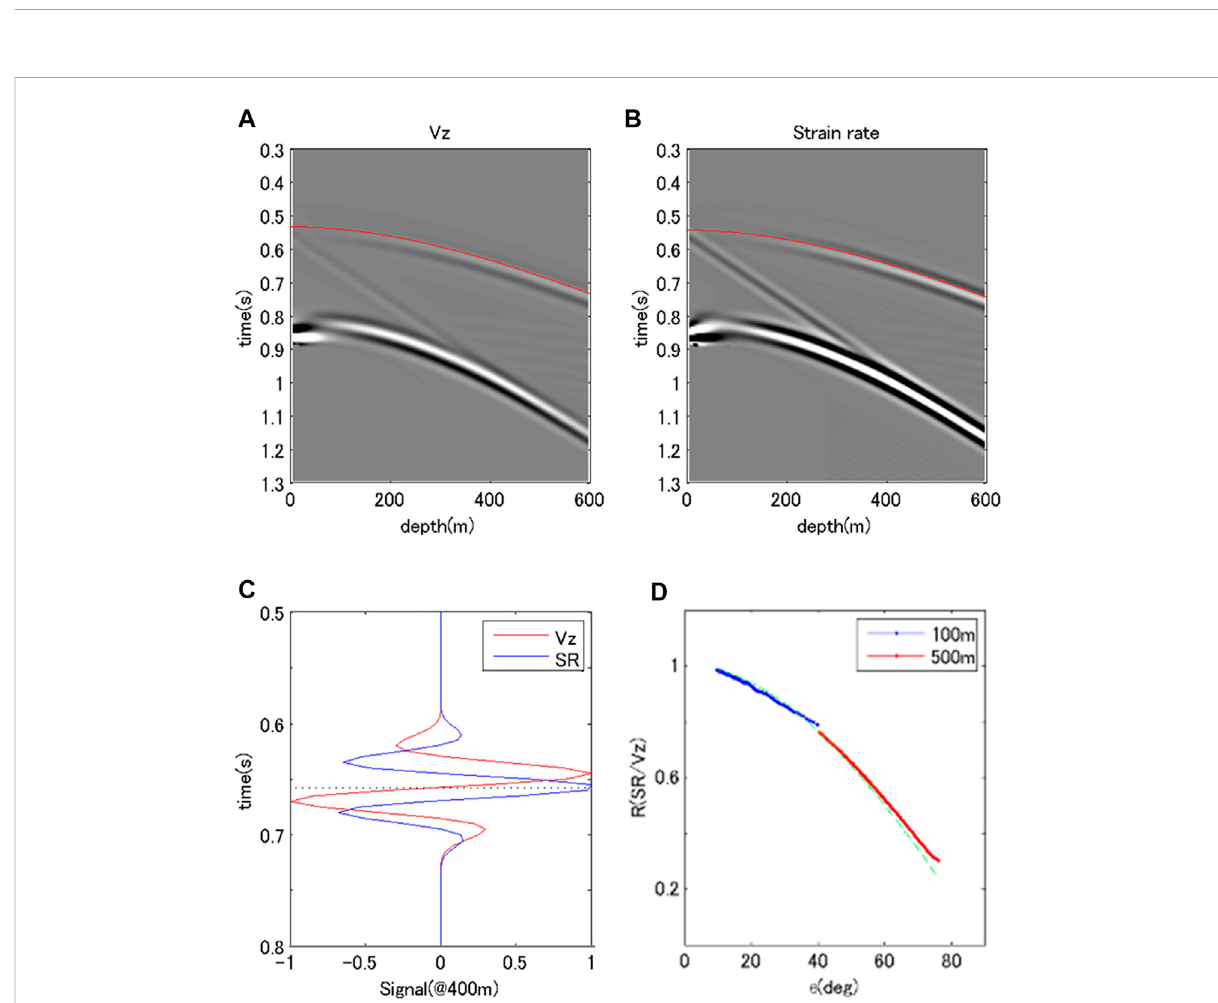
FIGURE 1 Characteristics of the synthetic wave fi eld in a homogeneous model. (A,B) show shot gather with the z components of the particle velocity and the calculated strain rate, respectively. Overlapping red lines correspond to the fi rst P-wave. (C) shows the wave fi elds around the P-wave arrival by particle velocity(red)and calculated strainrate (blue) atadepth of400 m. Theamplitudewas normalizedwith themaximumabsolutevalueequal to 1. (D) represents the P-wave amplitude ratio of strain rate/particle velocity. The colored lines correspond to the difference in the source offset; blue: 100 m, red: 500 m. The green line is the reference of the cos θ